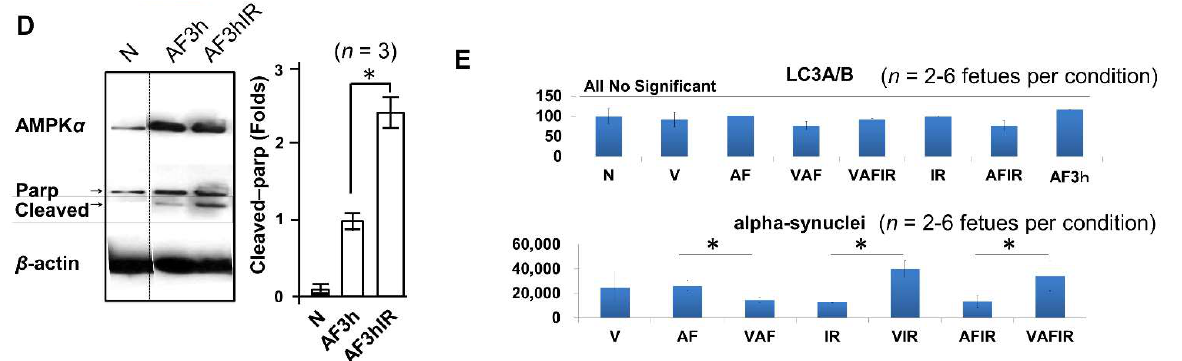
Figure 2. Amniotic LPS causes fetal death. ( A ) Dead fetuses were counted in the AF (red) and VAF (blue) groups from the endpoint 3 h. Almost all fetuses died by liquefactive necrosis of brains after 24-h exposure to amniotic LPS, even after vaginal LPS preconditioning. ( B ) An increased cleaved Parp protein (10 folds) supports the apoptosis-like cell death in the AF. ( C ) Significant cell death occurred in indicated concentrations (AF). ( D ) Protein level of cleaved Parp in the indicated conditions ( E ) Protein level of LC3A/B and alpha-synuclein (SNCA) in the fetal brain at different condition by western blot. * p < 0.05.